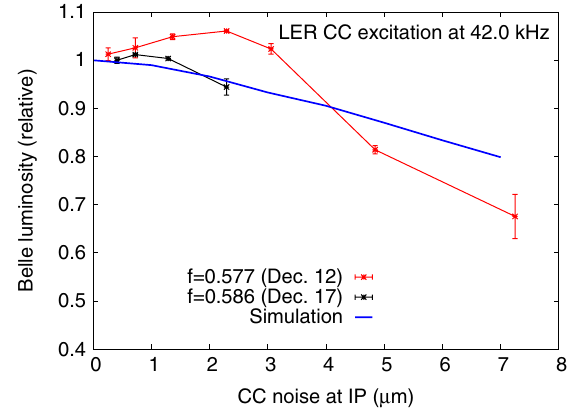
FIG. 15. Luminosity versus LER crab-cavity noise (harmonic excitation) as extrapolated to IP displacement. The excitation frequency (0.577 in tune units) is close to the LER vertical tune. The nominal IP horizontal beam size is 160 (cid:3) m .